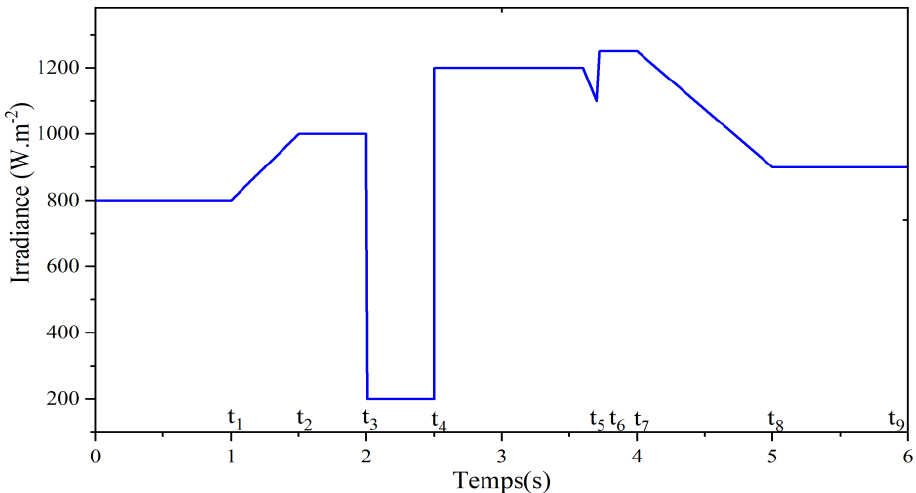
Figure 11. Irradiance profile used for simulation.